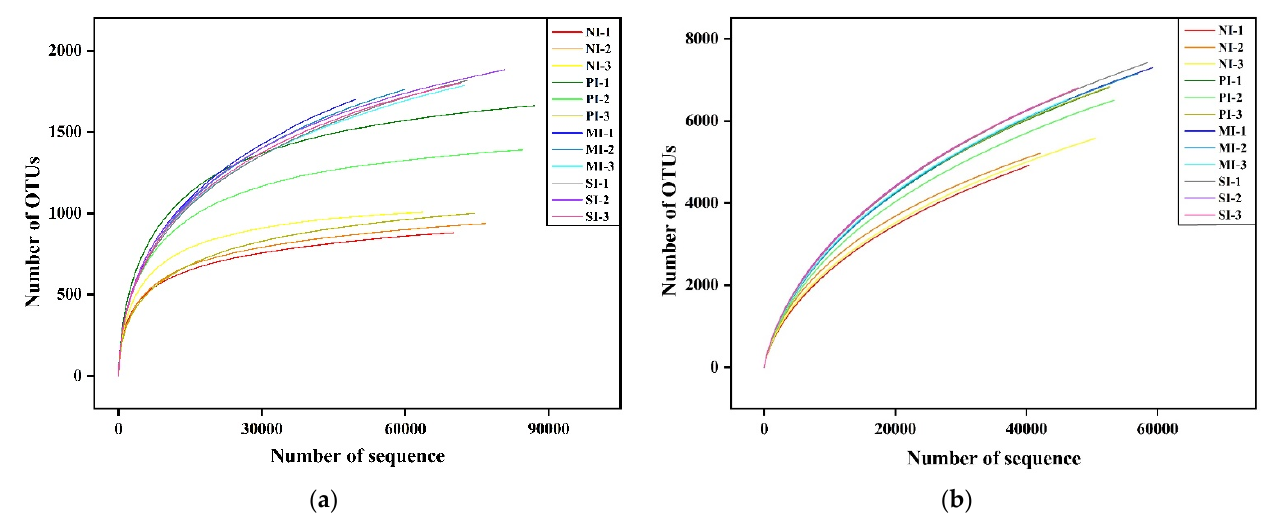
Figure 2. Fungi ( a ) and bacteria ( b ) rarefaction curves. NI, no invasion; PI, primary invasion; MI, moderate invasion; SI, severe invasion. OTUs, operational taxonomic units.